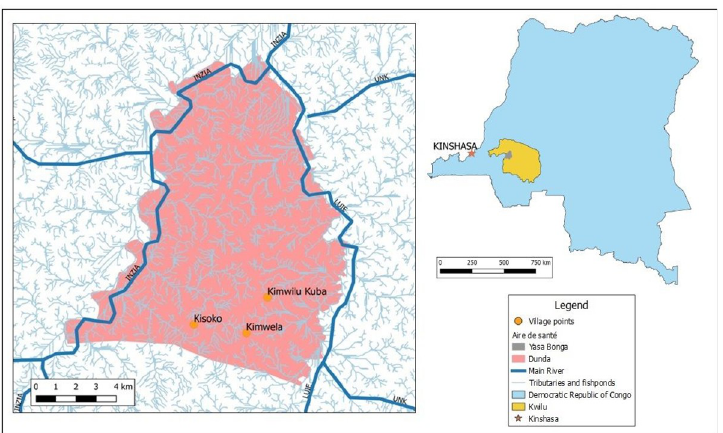
Fig 3. Location of the three pilot villages in the Dunda health area, Yassa Bonga health zone, Kwilu provinceplus de main rivers, tributaries and fishponds (Original work:CVK &